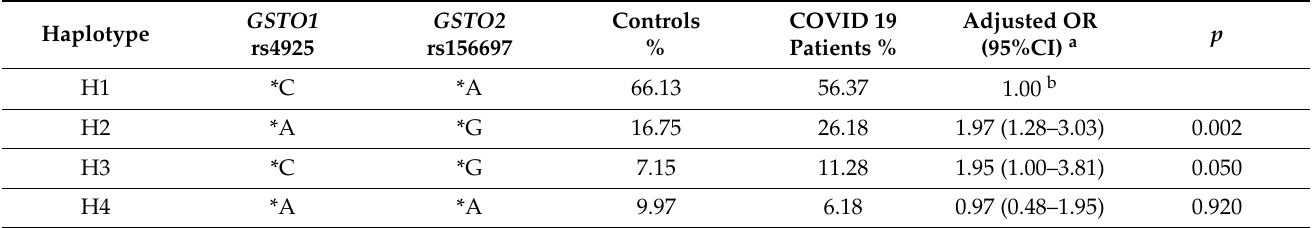
Table 4. Haplotypes of GSTO1 (rs4925) and GSTO2 (rs156697) in relation to the risk of COVID-19.